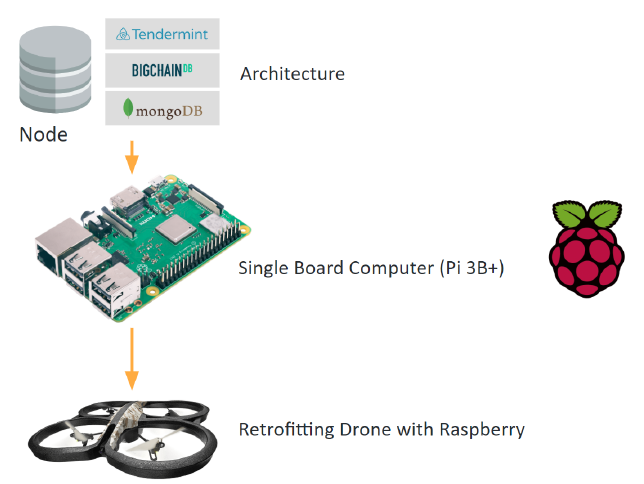
Fig. 3. Hardware used for the creation of physical agents